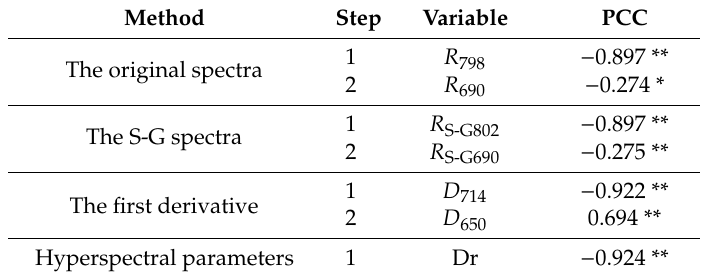
Figure 10. Results of the one-way ANOVA of the hyperspectral parameters. ( A ) Dr, SDy, SDb, and Db. ( B ) SDr, SDnir, and (Rg − Rr) / (Rg + Rr). ( C ) SR1, Rg / Rr, and SR2. a, b, c and d indicate that the damage degree is significantly di ff erent at this parameter ( p < 0.05), while the same letter indicates that there is no significant di ff erence. Table 8. Variable screening results of di ff erent spectral processing methods. Screening results were processed through stepwise discriminant analysis. PCCs are the results of the Pearson correlation